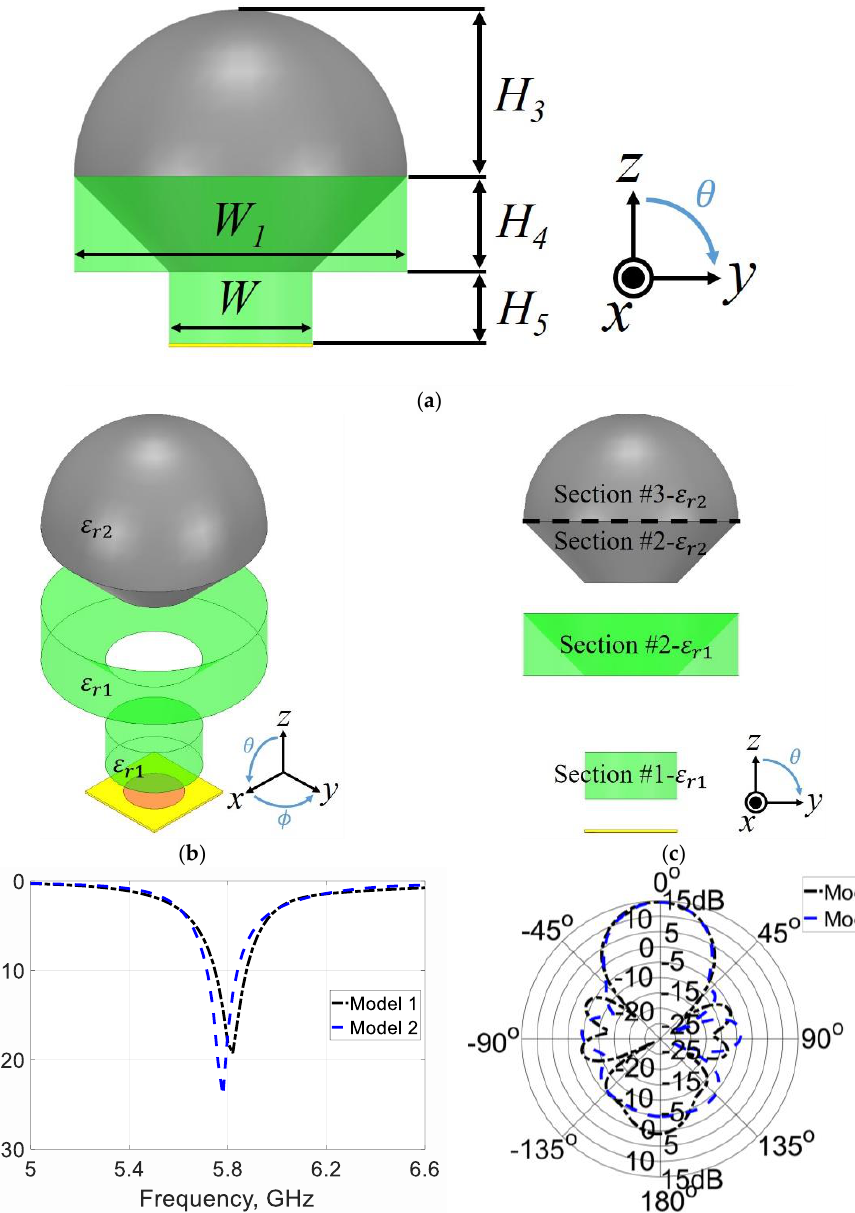
Figure 2. Dielectric lens antenna (model 2) simulation. ( a ) Simulation model. ( b ) Perspective view of the lens (disintegrated). ( c ) Side view of the lens (disintegrated). ( d ) Reflection coefficient. ( e ) 𝜃 - sweep radiation pattern ( 𝜙 = 0° ). The design parameters are H 4 = 20, and H 5 = 15. All units are in millimeters.